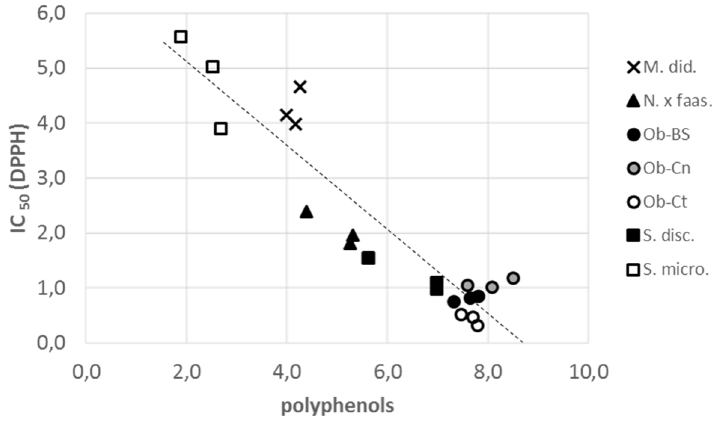
Figure 2. Correlation between polyphenols content in Lamiaceae flowers and the radical scavenger activity (DPPH). Straight line equation: y = − 0.7654x + 6.6163; R 2 = 0.8698 148